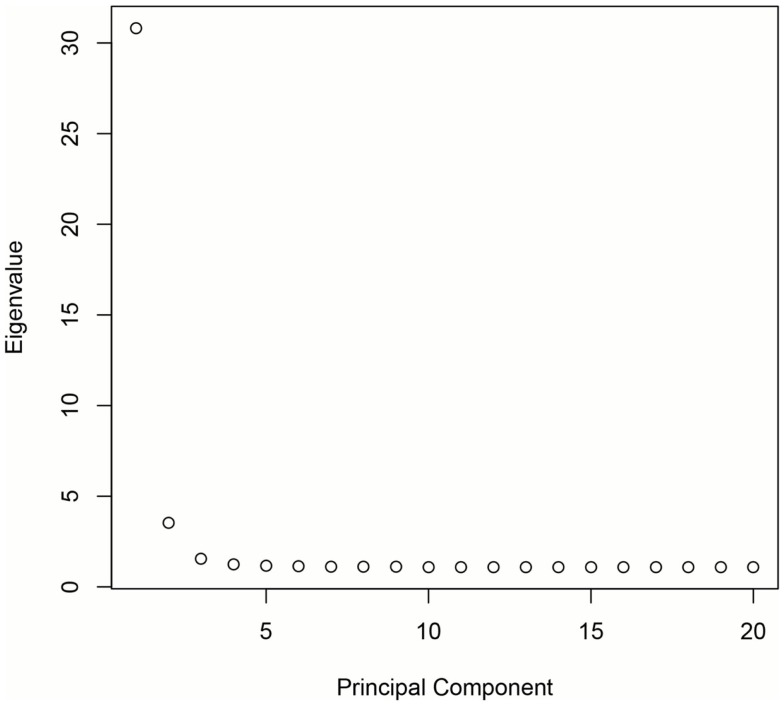
Scree plot demonstrating that the majority of genetic variation is explained by the first three PCs.